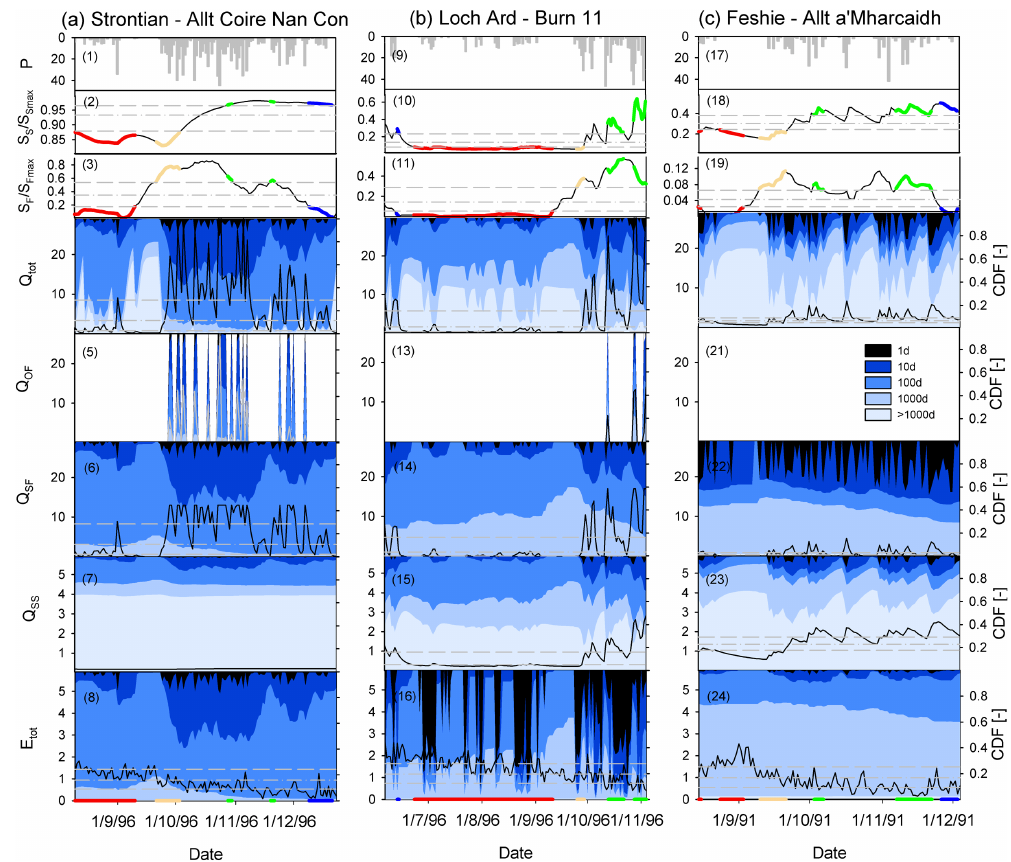
Fig. 11. Flux water age distributions p F from the PM scenarios and following a full sequence of hydrologic regimes: dry (red) – wetting-up (yellow) – wet (green) – drying-up (blue) for the three study catchments. The first row shows the daily precipitation, the second and the third rows show the normalized states of S S and S F used to define the hydrologic regimes (see Fig. 5). Rows 4 to 8 show the absolute flux of the respective component (black line), the long-term means and respective standard deviations of the individual fluxes and the color shades from dark to light indicate the cumulative proportions of water younger than 1d, 10, 100, 1000d and older than 1000d contributing to the individual fluxes at each time